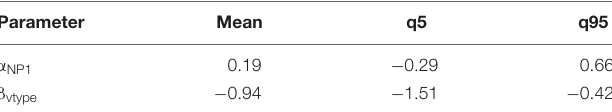
TABLE 12 | Mean estimate and credible interval for the parameters of the Expectancy model, Experiment 2.